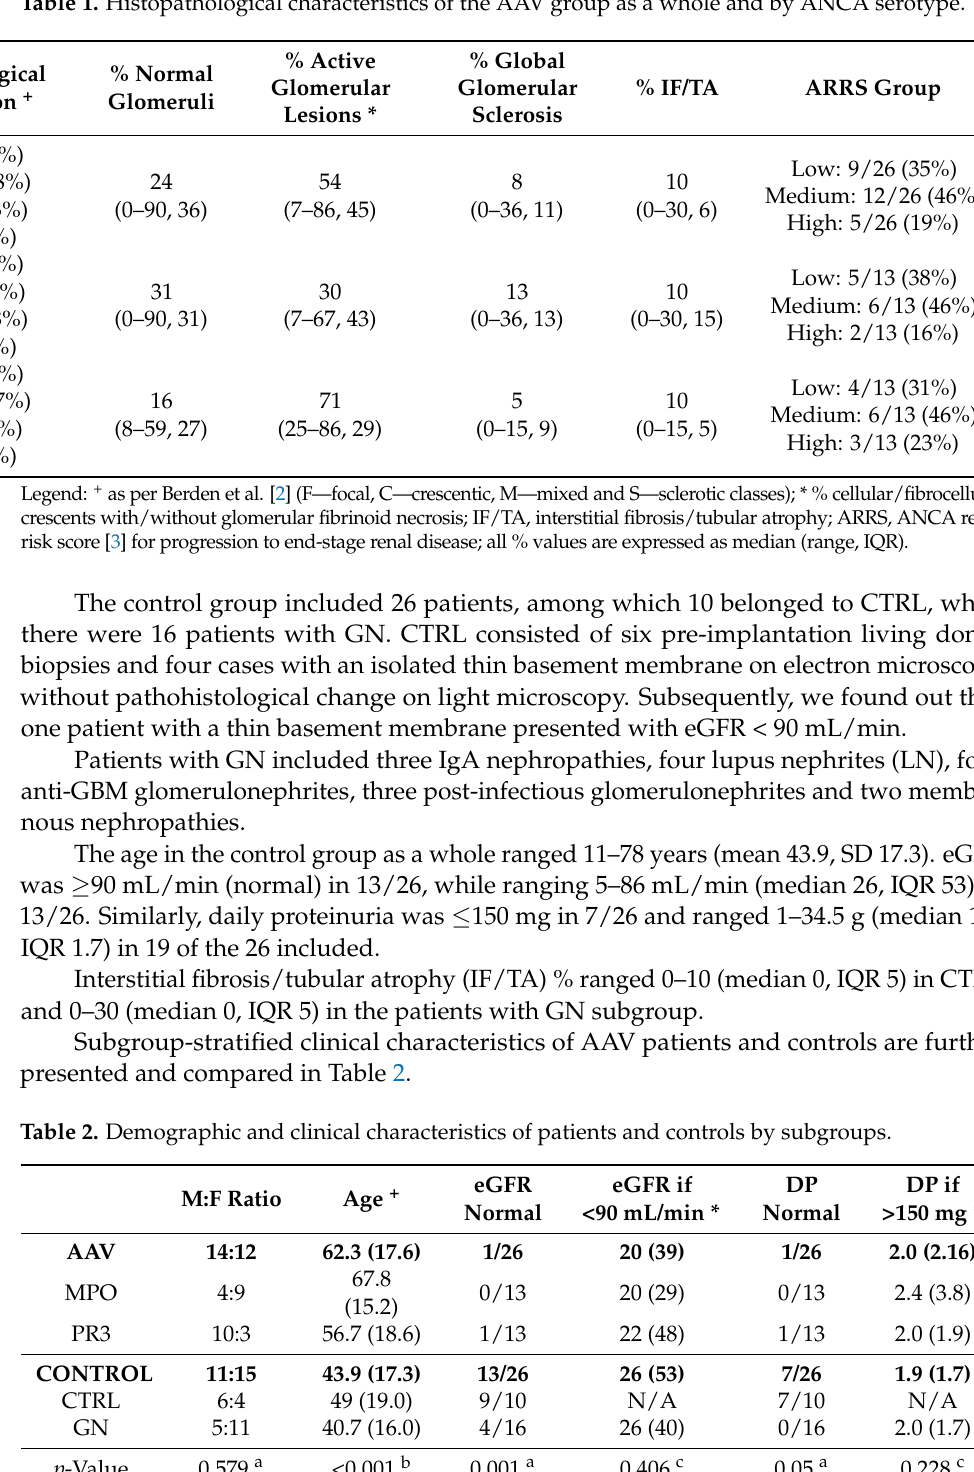
Table 1. Histopathological characteristics of the AAV group as a whole and by ANCA serotype.